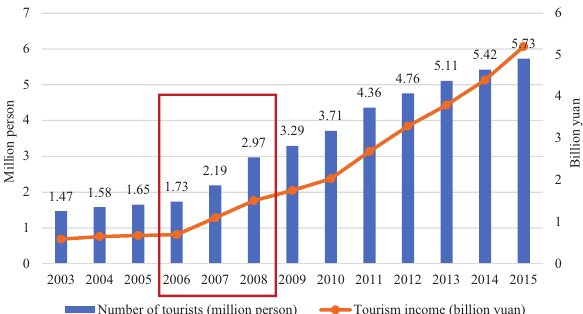
Figure 3. Number of tourists and tourism income in Kaiping from 2003 to 2015 (source: Statistics Communique on National